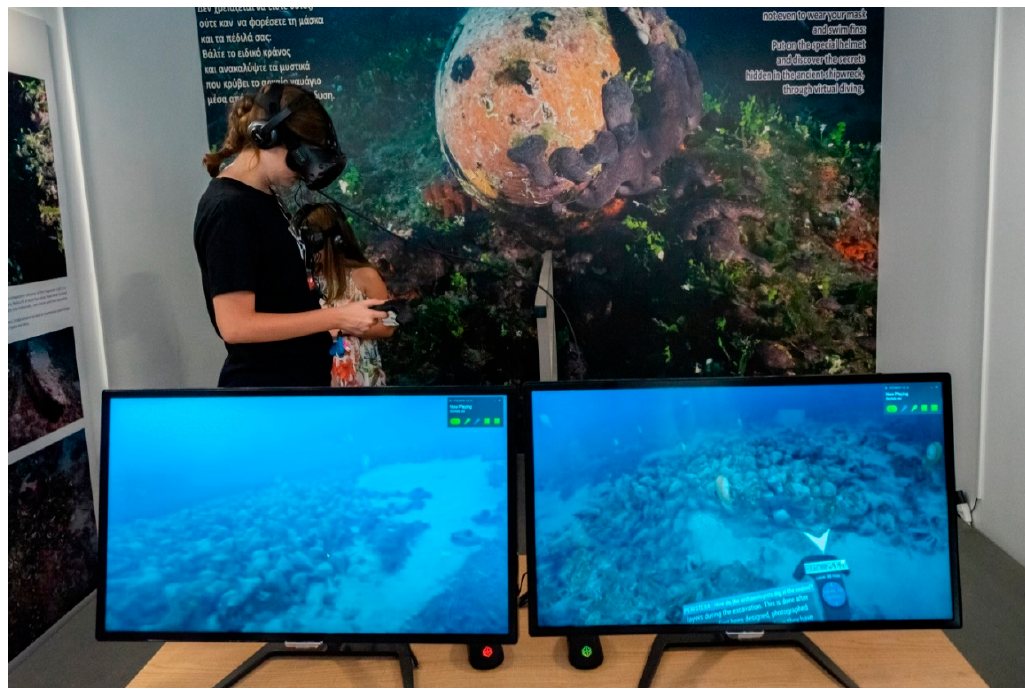
Figure 2. Virtual diving system.